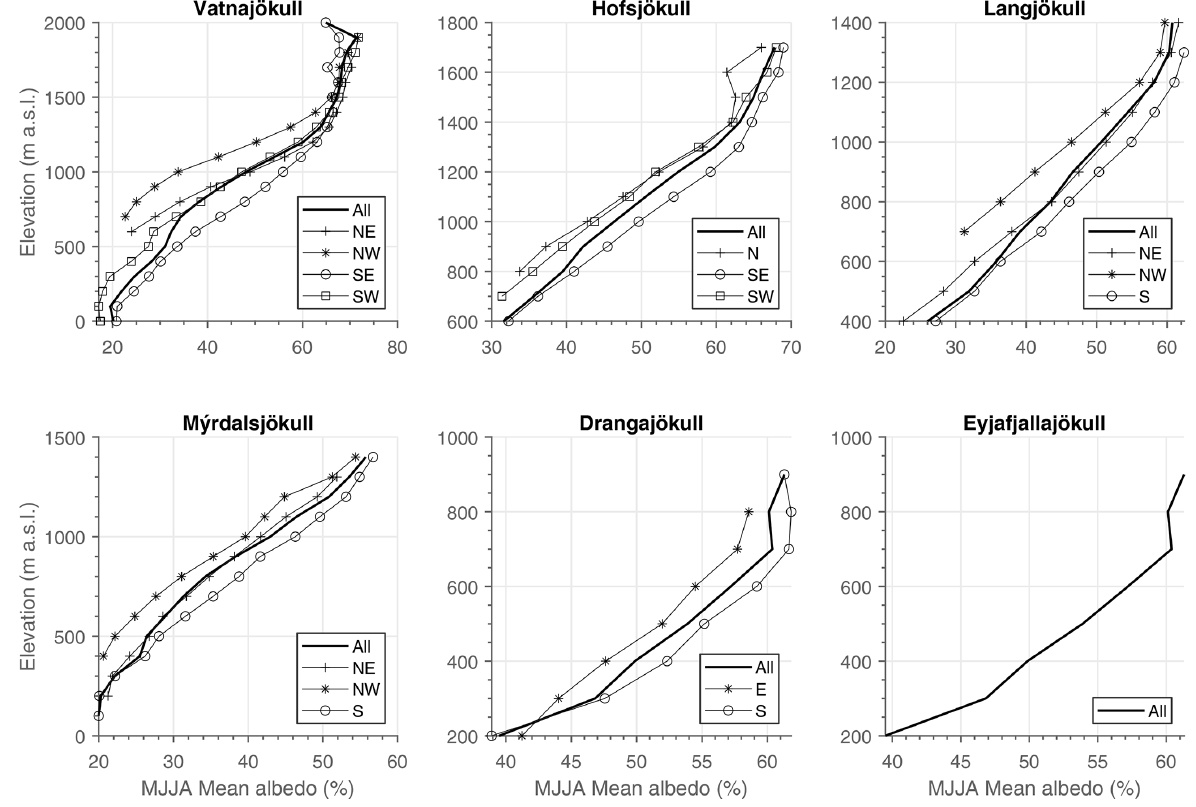
Figure 5. Average albedo for the period as a function of elevation for the period 2000–2019. Data are shown for the six largest ice caps for the whole glaciers (All) as well as for the sub-areas defined in Fig. 1. Note the elevation range varies between figure axes ( y axis).